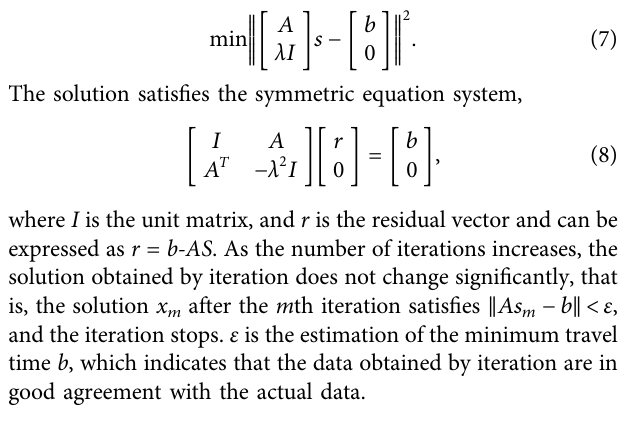
Frontiers in Earth Science |